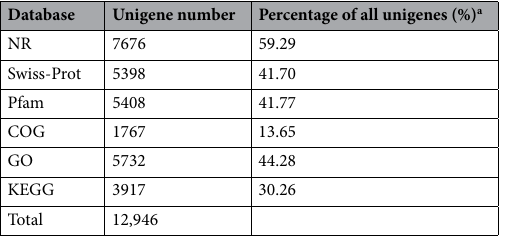
Table 1. Number of C. comatus unigenes that matched with sequences in the indicated databases (E-value < 10 –5 ). a Percentage of the total number of C. comatus unigenes (12,946) matched to the indicated database.